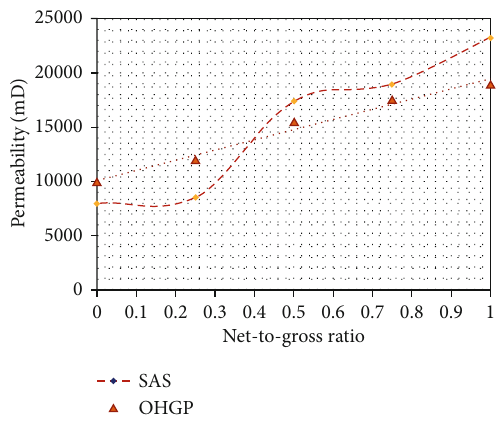
Figure 9: The e ff ect of di ff erent NTG on the permeability of the